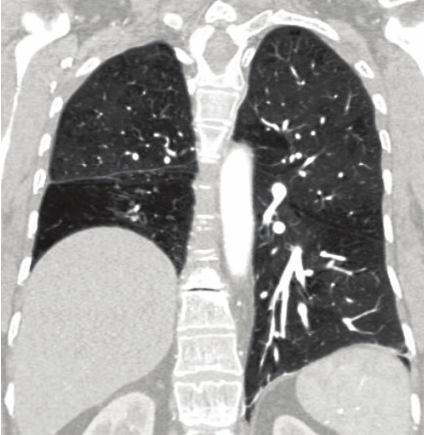
Figure 3: On coronal CT image, emphysema and parenchymal scars were seen in the lower lobe of the right